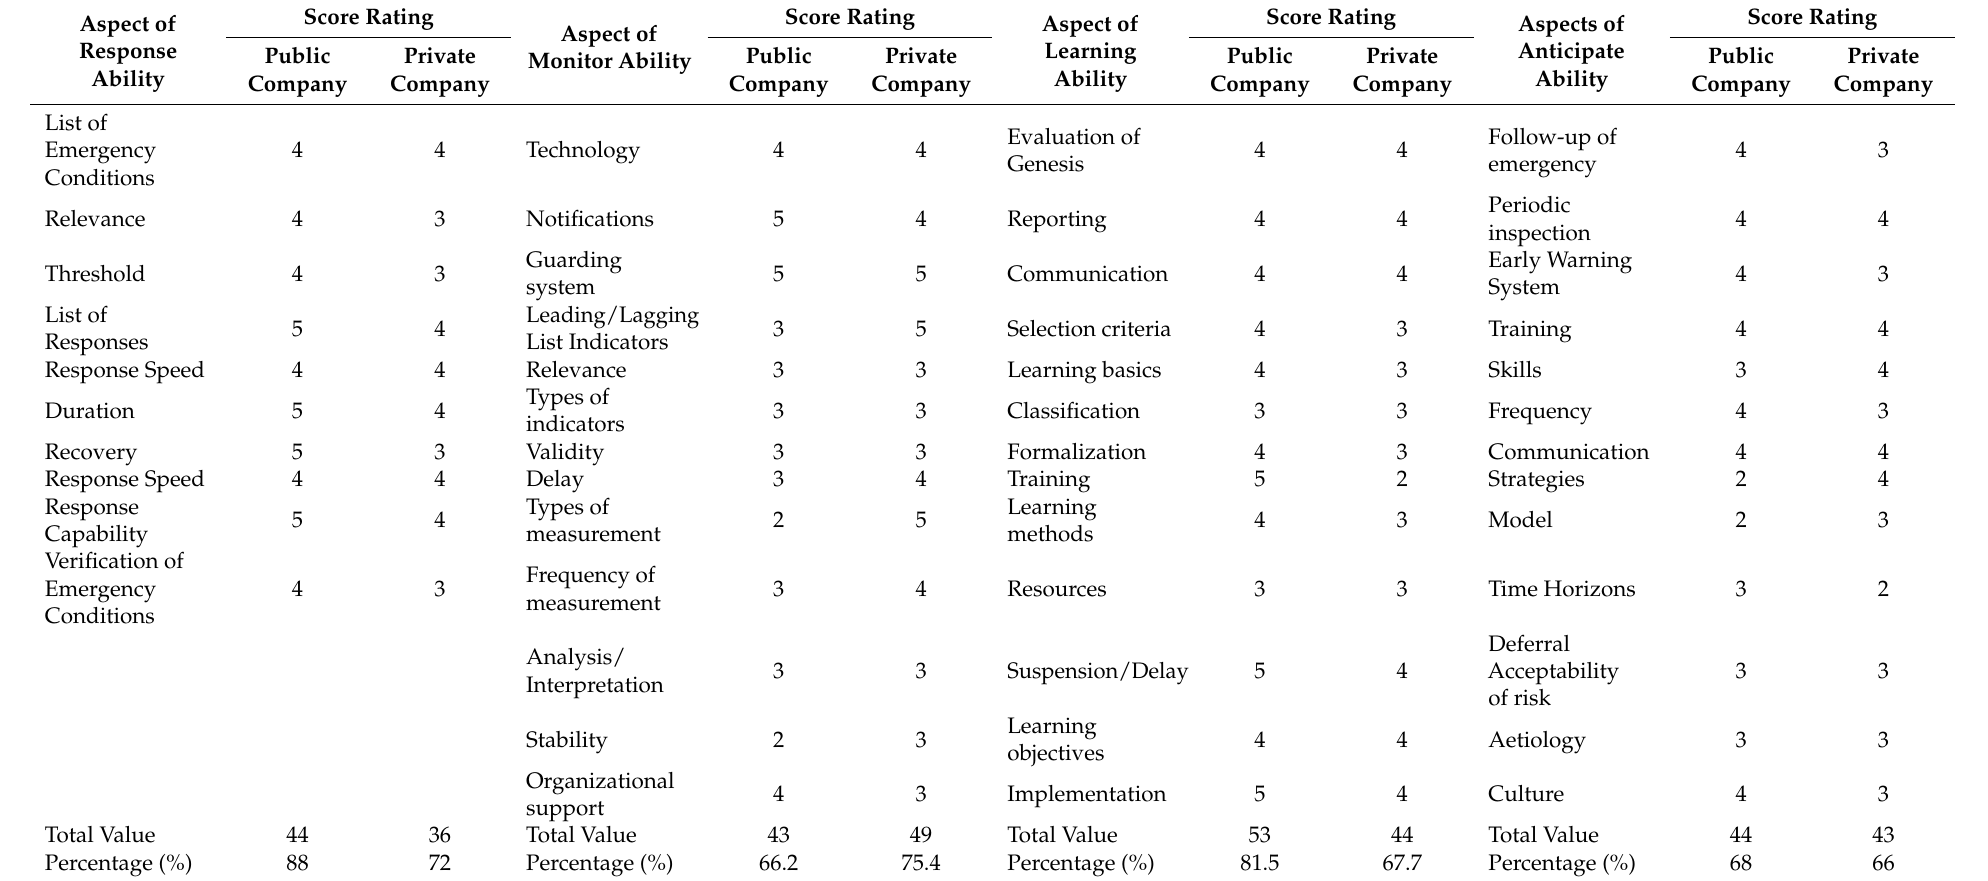
Table 1. Calculation for each aspect of